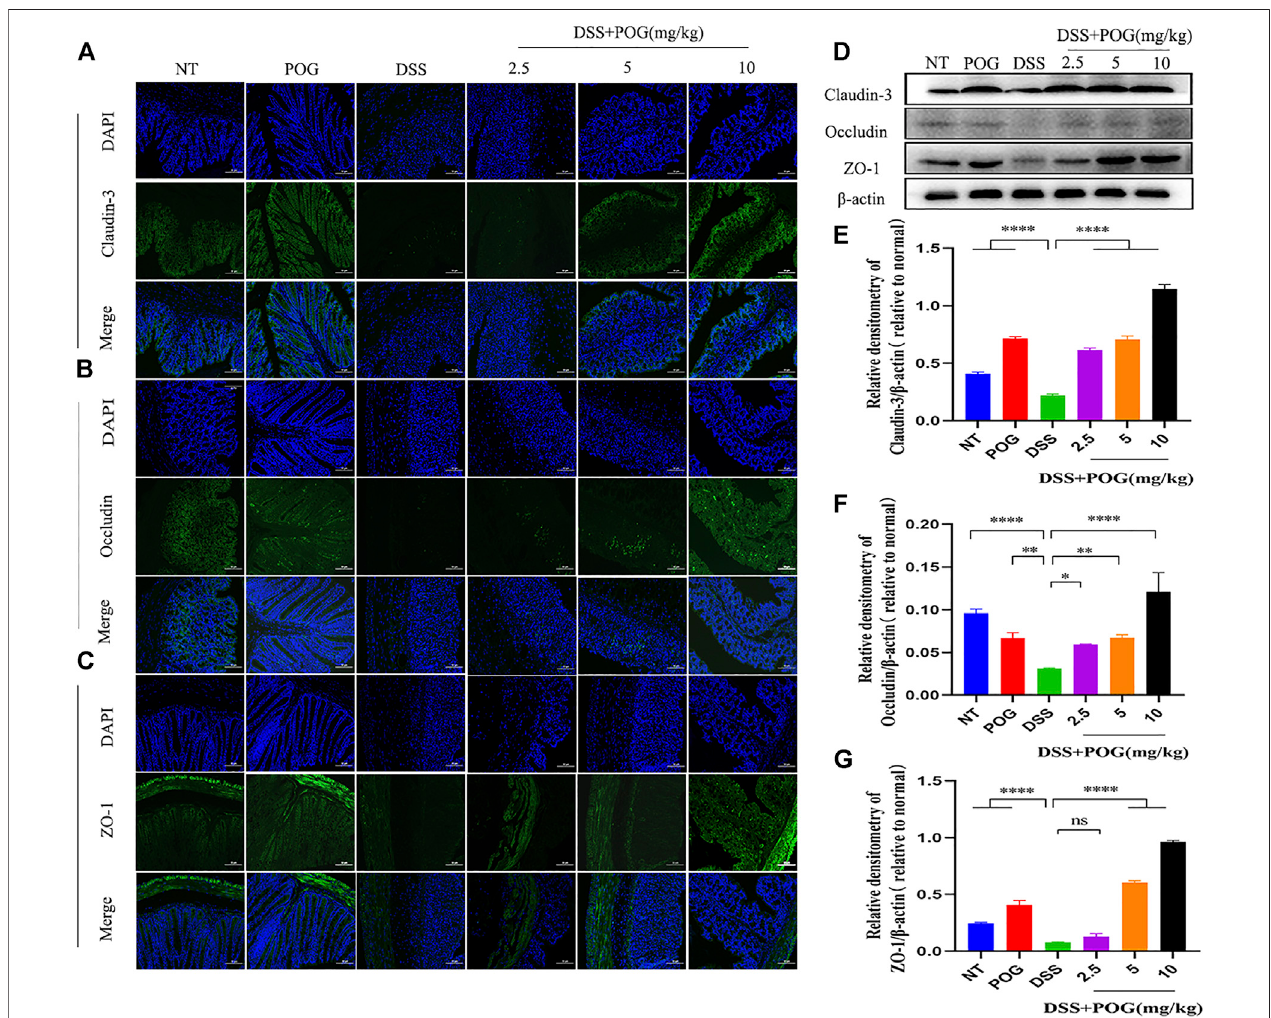
FIGURE 4 | The effect of POG on tight junction protein induced by DSS in mice UC model. (A – C) The three TJ proteins Occludin, ZO-1, and Claudin-3 were analyzedthrough IFstaining(20×);scale bar:50 µm. (D – G) WesternBlot method wasused todetect the threeprotein levelsofOccludin, Claudin-3, and ZO-1. Dataare means ± SD ( n = 3). *p < 0.05, **p < 0.01, ***p < 0.001, ****p <